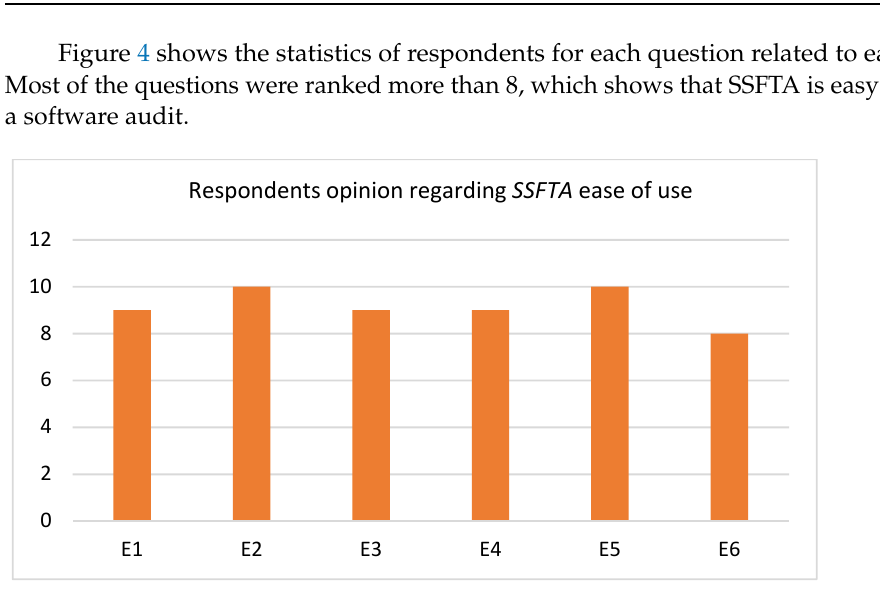
Figure 4. The evaluation of SSFTA for usability and ease of use .